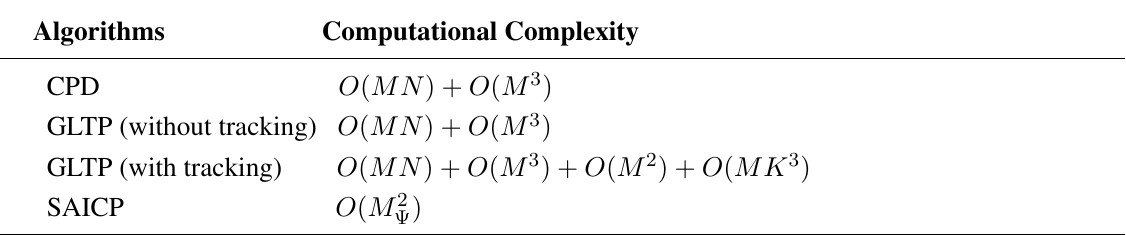
Table 1. Computational complexity of three registration